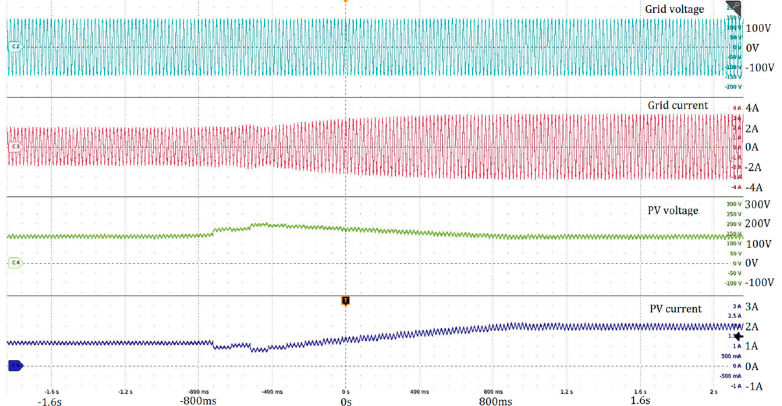
Figure 15. Responses of grid-connected and PV-connected inverters under MPPT control when the resistor R changes from 100 W to 60 W. Energies 2018 , 11 , x FOR PEER REVIEW